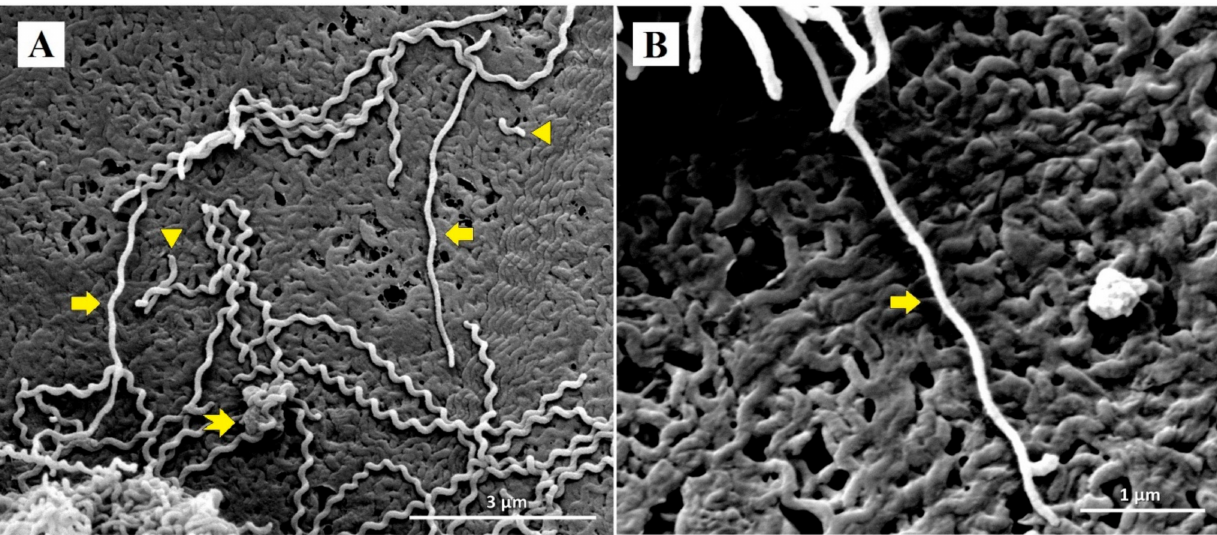
Figure 3. SEM micrographs of L. interrogans serovar Australis treated with MIC doxycycline at 30,000 × ( A ) and 60,000 × ( B ) magnifications. Block arrows: less coiling and thinning in Leptospira diameters; notched arrow: blebbing; arrowhead: short-